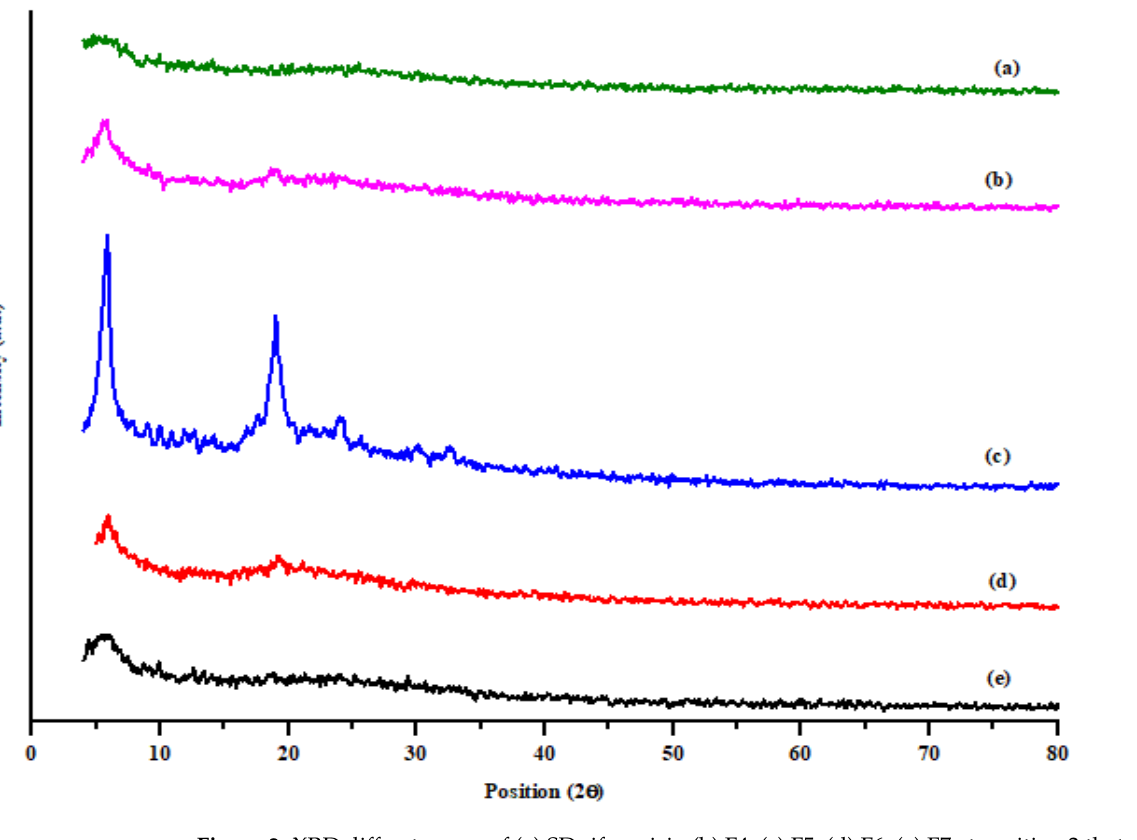
Figure 2. XRD diffractogram of (a) SD rifampicin (b) F4, (c) F5, (d) F6, (e) F7 at position 2 theta and intensity 4 to 80 (arbitrary scale).